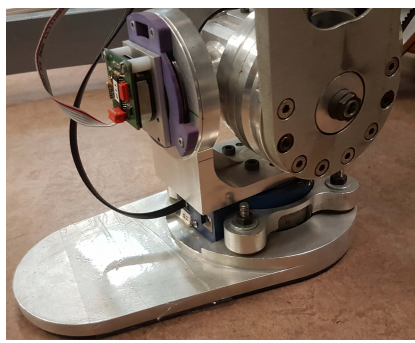
Figure 4. The TEO robot’s ankle joints with the force–torque